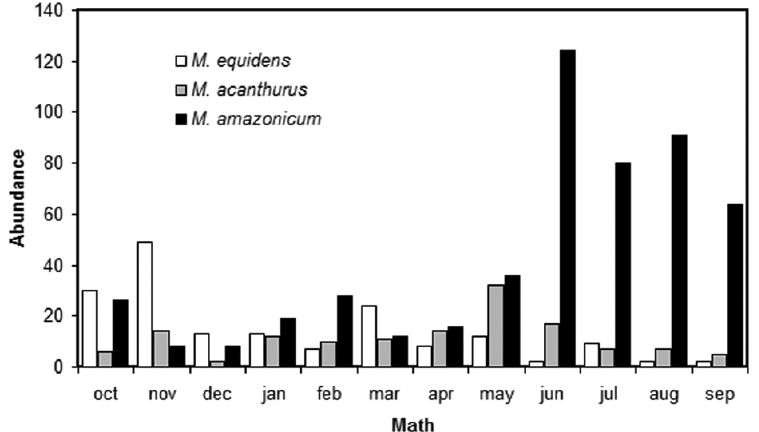
Fig. 5 – Number of specimens of different Macrobrachium species captured in the Caeté Estuary between October 2001 and September